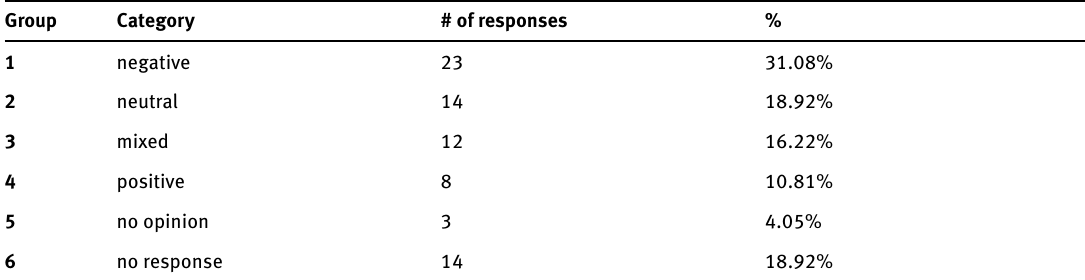
Table 4. Attitudes towards Konglish